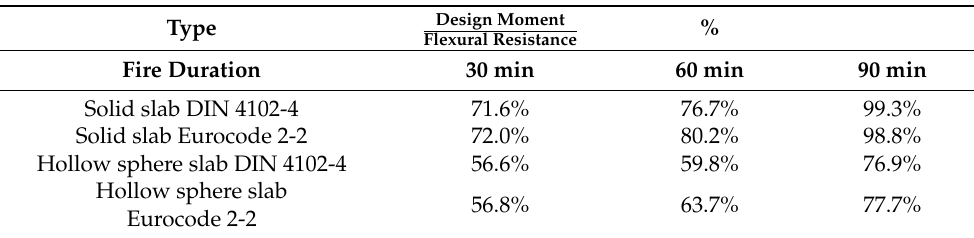
Table 4. Utilization of flexural resistance of the different slab types after 30, 60 and 90 min of fire exposure (with design moment cf. Table